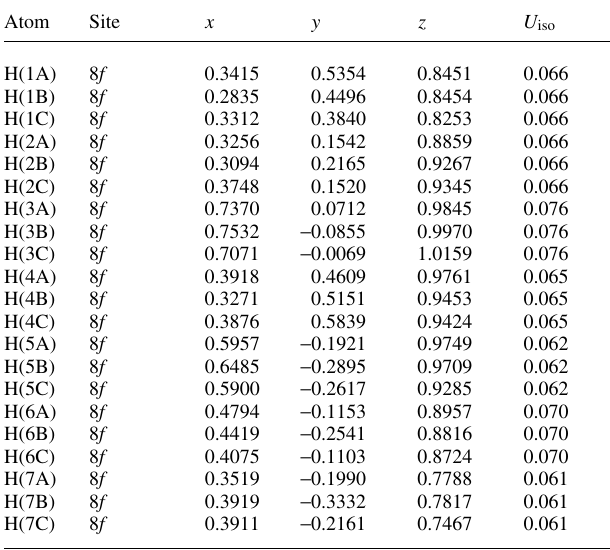
Table 2. Atomic coordinates and displacement parameters (in Å 2 )